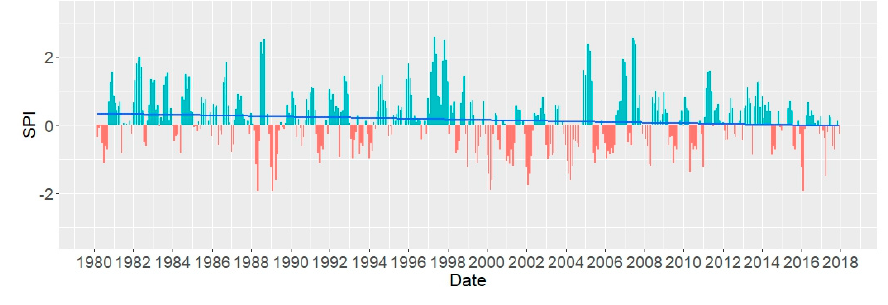
Figure 10. Three-month SPI of the Panjgur station.